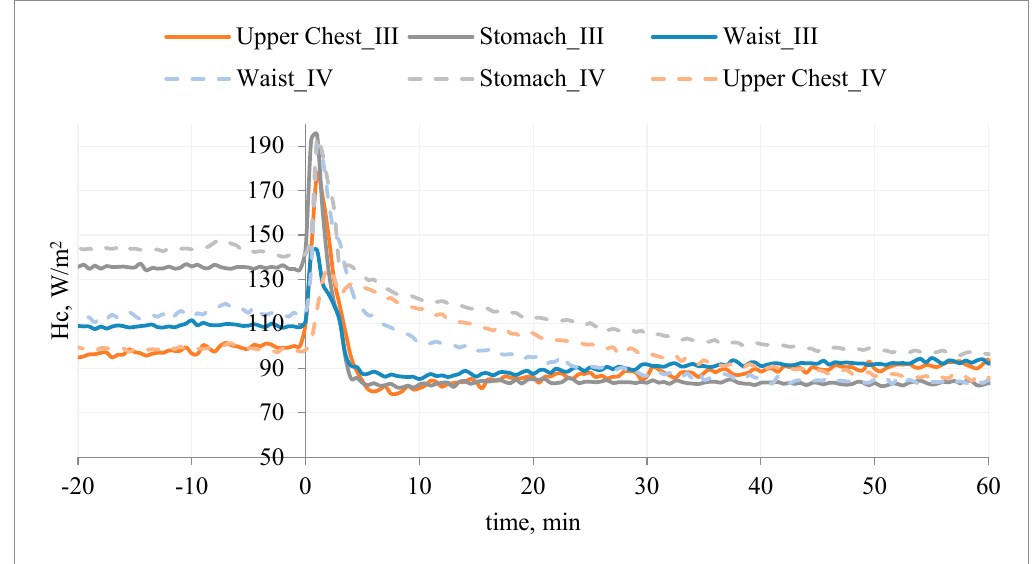
Figure 12. An example of the heat flux density, Hc, on selected manikin segments (chest) during the test of T-shirt A without PCM together with outer garments (variant III) and T-shirt A with PCM together with outer garments (variant IV).